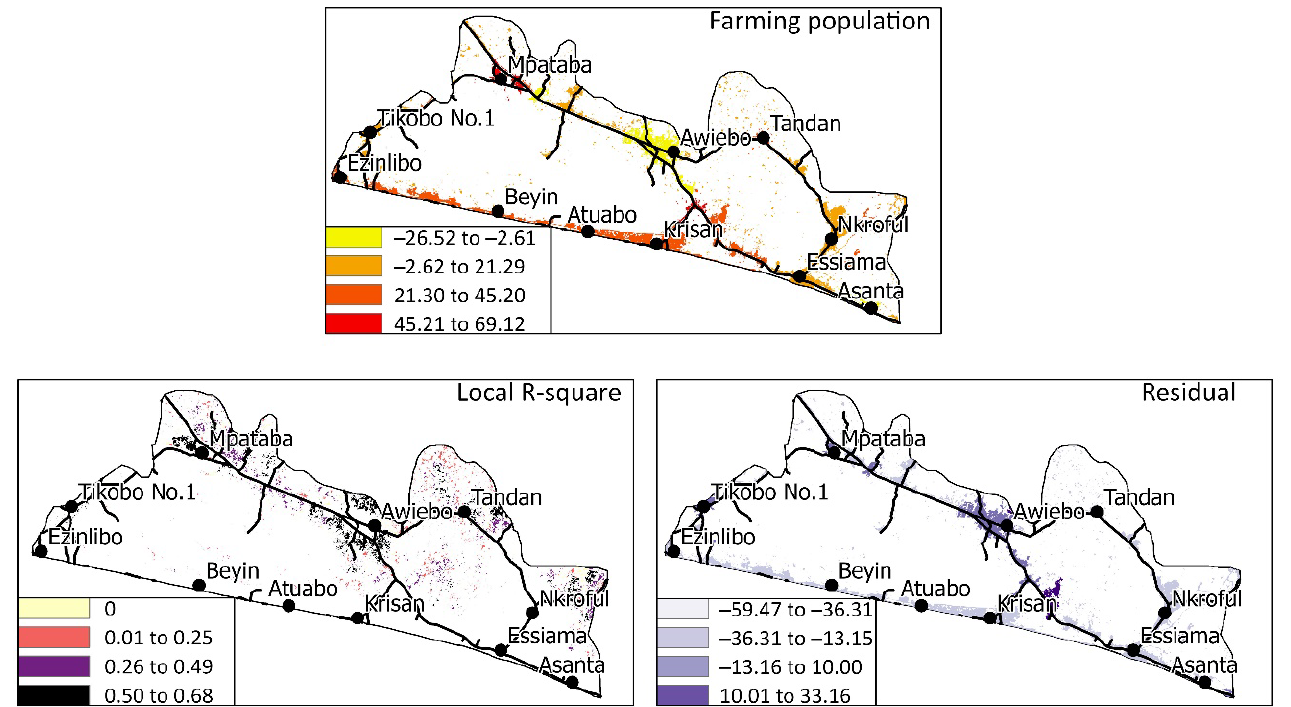
Figure 10. Results of geographically weighted regression showing spatial variations in the relationships between elevation, slope, distance from road, farming population, total resident population and land use/land cover transitions to rubber plantation. Positive coefficients indicate the magnitude of spatial variation. Negative coefficients indicate no spatial correlations between the factor and transitions to rubber plantation.